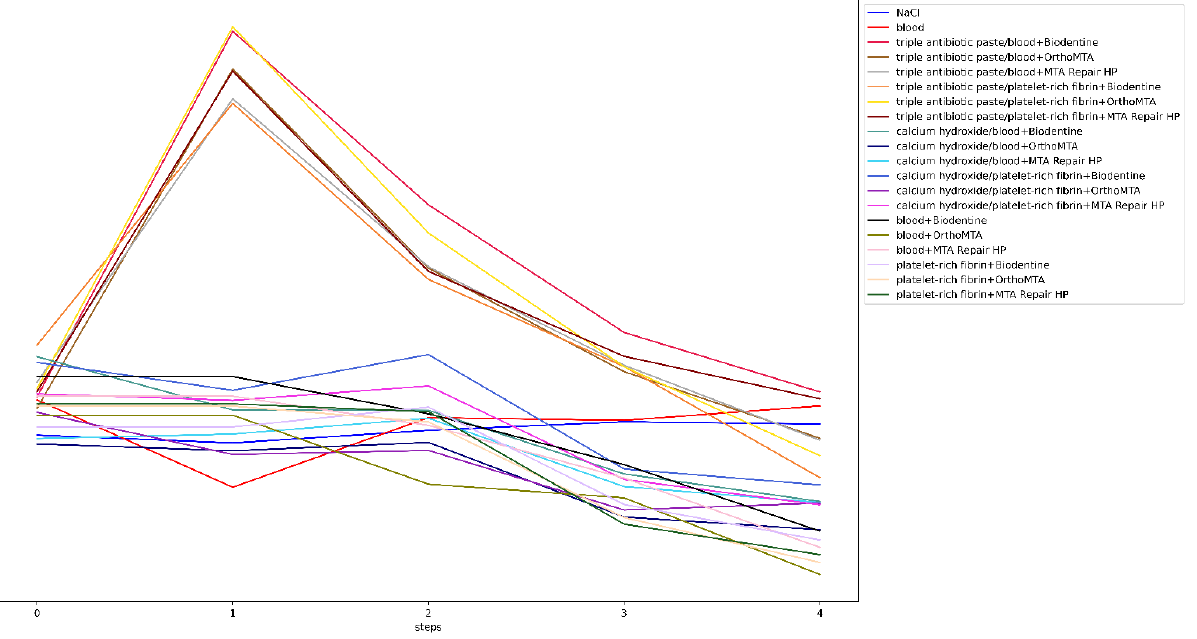
Figure 8. Values of b for all groups and steps. In step 2, after applying the scaffold and barrier material, the specimens of only one group, that is, group 20, showed no visible colour change ( ∆ E = 2.62). Between steps 1 and 2, the highest ∆ E value was reported for the groups in which triple antibiotic paste was used earlier. Despite the use of different scaffolds and barrier materials, no significant colour change was observed between the groups with triple antibiotic paste ( p > 0.005). In step 2, the L value for groups with triple antibiotic paste decreased significantly compared with that in step 1. The ∆ E value did not differ significantly in the triple antibiotic paste groups in which blood was applied as a scaffold, in comparison to the equivalent groups with calcium hydroxide and single-visit regenerative endodontic procedure groups. In the triple antibiotic paste groups in which platelet-rich fibrin was used, when compared to the matching groups without triple antibiotic paste, statistical significance was noted. When comparing the ∆ E value in groups in which calcium hydroxide was applied previously and replaced with a scaffold and barrier material to the corresponding single-visit regenerative endodontic procedures groups, no significant statistical changes were noticed between steps 1 and 2. The lowest ∆ E values in step 2 were achieved in the single-visit regenerative endodontic procedures groups with platelet-rich fibrin (group 20, ∆ E = 2.62; group 18, ∆ E = 3.94; group 19, ∆ E = 4.40). Comparing the single-visit regenerative endodontic procedures groups between steps 1 and 2, a significant difference was noticed between the blood and platelet-rich fibrin groups. The BB, BO, and BM groups showed significantly more discolouration than the corresponding platelet-rich fibrin groups, but it was not significant compared to the positive control group (group